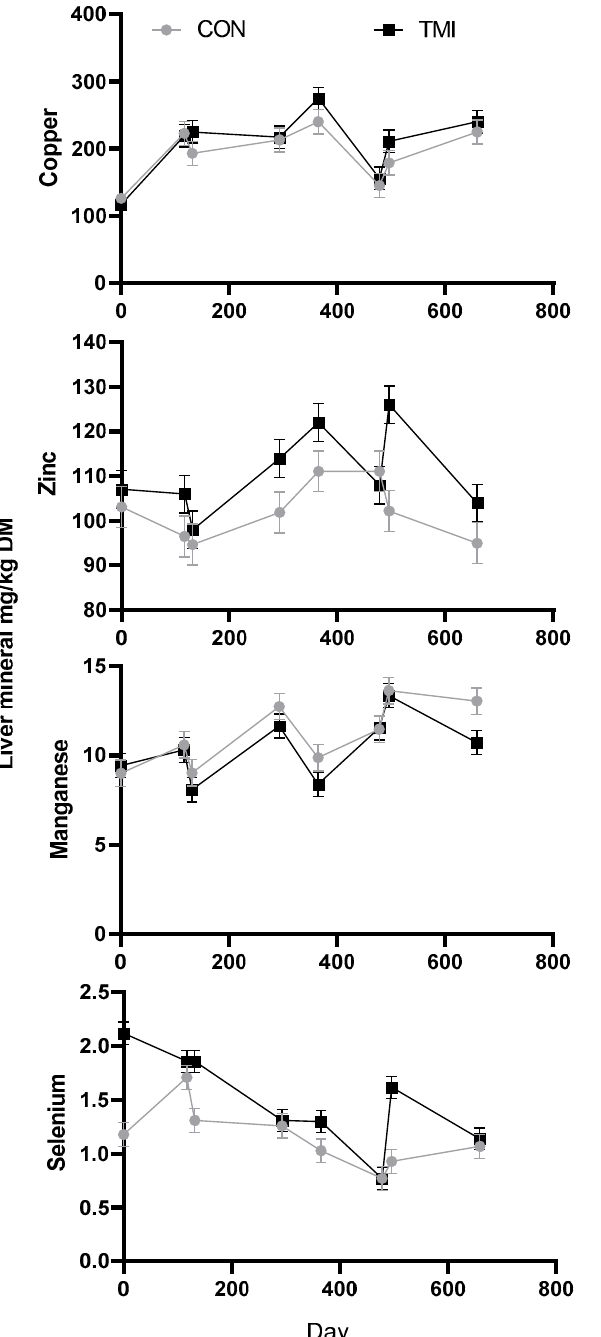
Figure 2. Effect of trace mineral injection (TMI) containing Cu, Se, Mn, and Zn or no injection (CON) on liver concentrations in beef cows over a two-year period. Injections were given pre-calving (days 0 and 365) and pre-breeding (days 117 and 478), and liver biopsies were taken prior to injection on those dates. Samples were also taken 15 to 18 days post pre-breeding TMI (referred to as breeding; days 132 and 496), and near weaning (days 293 and 632). Initial trace mineral concentration (day 0) was used as a covariate. Treatment by day effect not significant ( p ≥ 0.67) for Cu or Mn but tended to be significant ( p = 0.13) for Zn and was significant ( p < 0.01) for Se. Day effect was significant for all minerals ( p < 0.01). Treatment effect ( p ≤ 0.02) was significant for Mn, Se, and Zn and tended ( p = 0.06) to be significant for Cu.